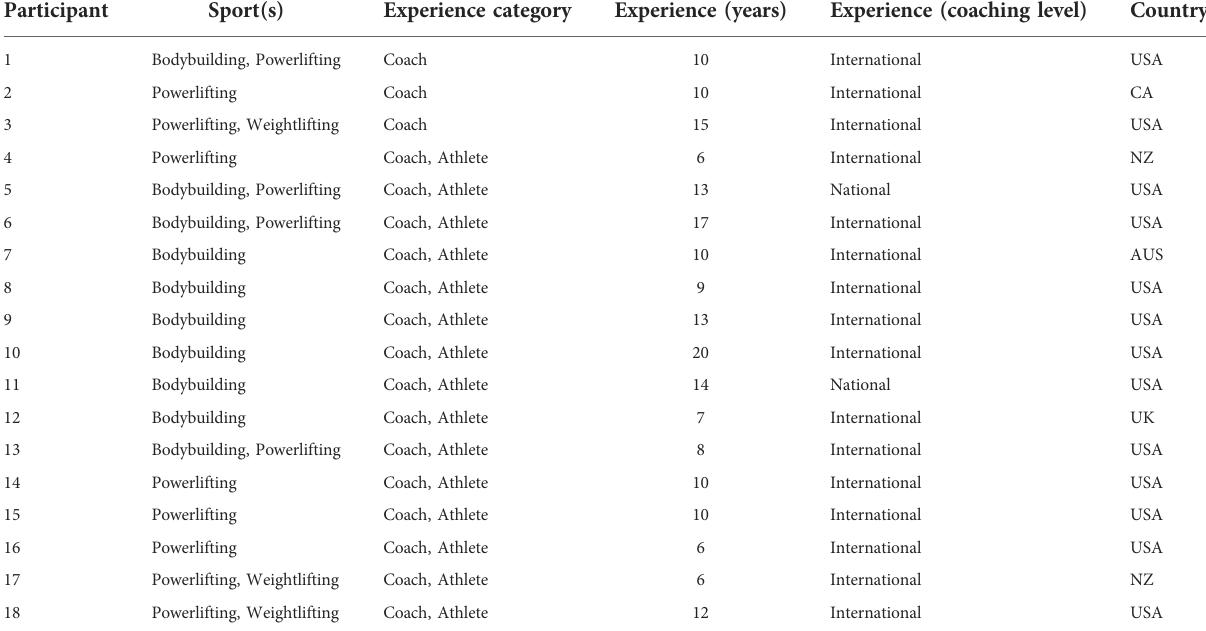
TABLE 1 Descriptive characteristics of